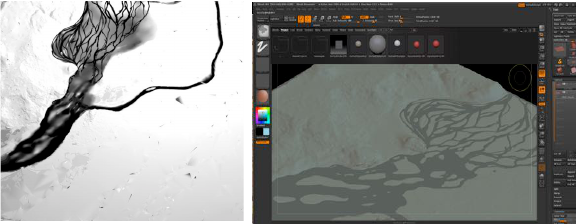
Figure 7. The creation of the ancient landscape, from depth map to 3D